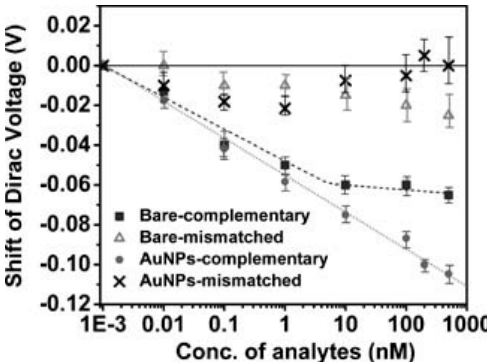
Figure 5. Shift in V D for the bare electrode and AuNP decorated G-FET when adding increasing concentrations of complementary DNA and one-base mismatched DNA. Reprinted from [54].